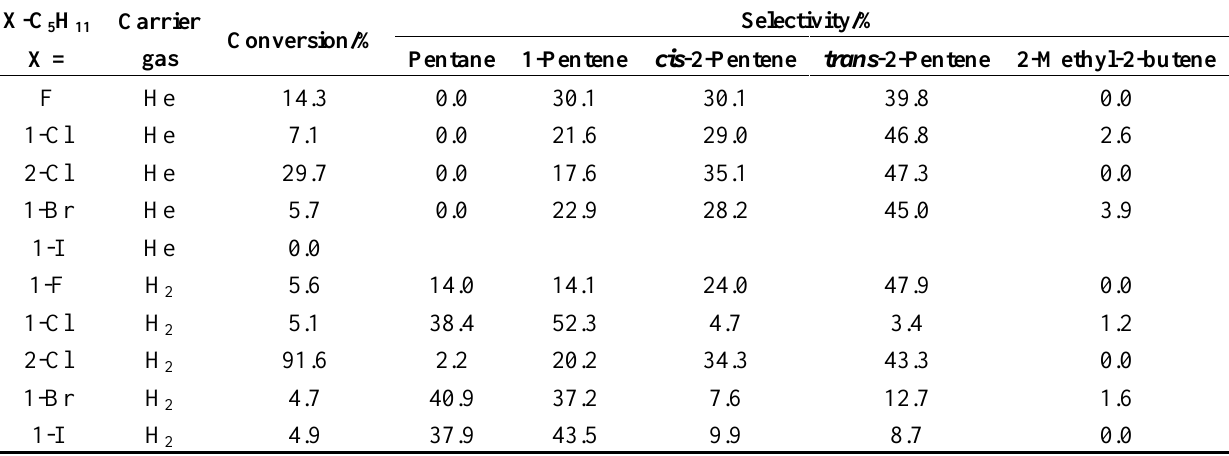
Table 13. Dehydrohalogenation and hydrodehalogenation of halogenated pentanes a . over Re Cl 3 9